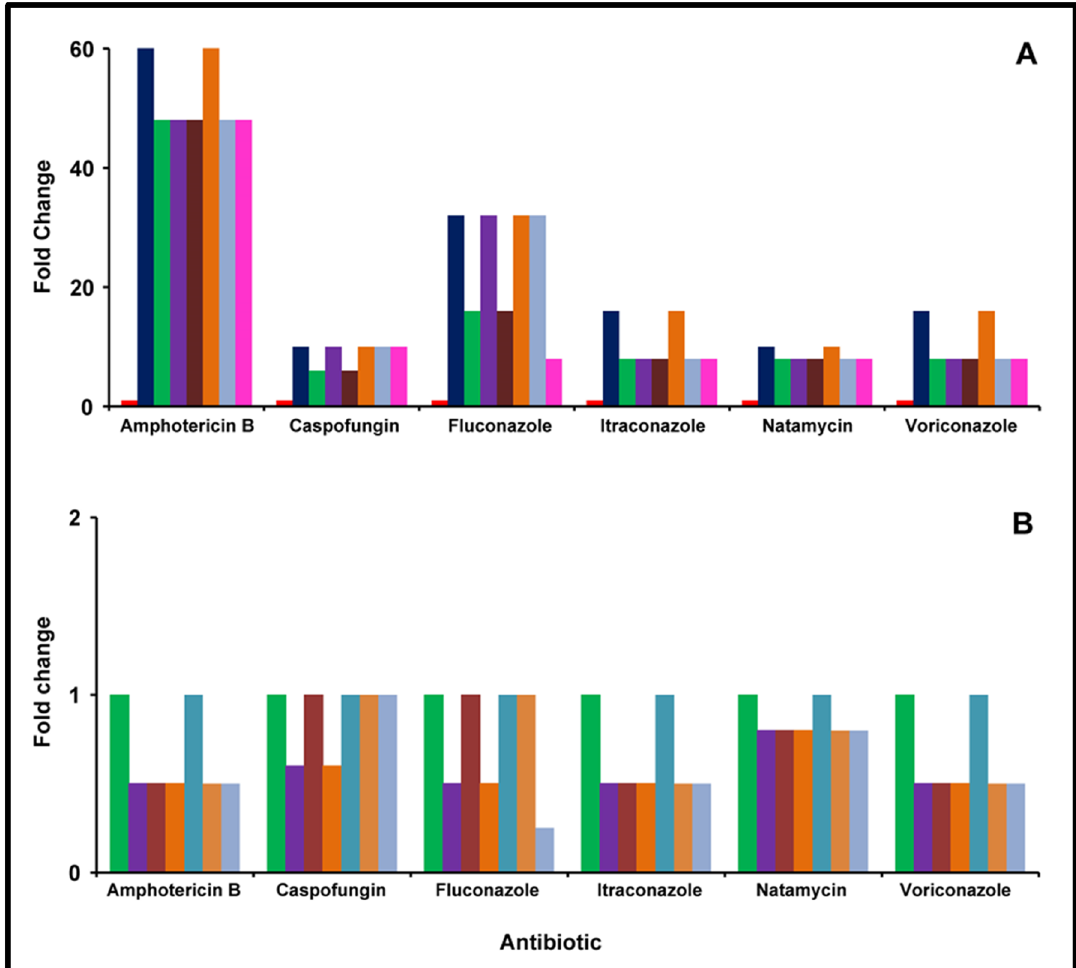
Figure 8. Fold change in the minimum biofilm eradication concentration (MBEC) of the antifungal agent of monomicrobial ( C. albicans ) and polymicrobial ( S. epidermidis plus C. albicans and S. aureus plus C. albicans ) biofilms compared to planktonic cells of C. albicans ( A ) and comparison of MBEC between monomicrobial ( C. albicans ) and polymicrobial ( S. epidermidis plus C. albicans and S. aureus plus C. albicans ) biofilms ( B ). The effect of the antimicrobial agent was evaluated by the XTT method as described. The coloured bars indicate the following: red square, C. albicans in the planktonic phase (24 h); blue square, C. albicans in the biofilm phase (24 h); green square, S. epidermidis plus C. albicans simultaneously incubated to form biofilm (24 h); purple square, C. albicans biofilm preformed for 24 h and then S. epidermidis planktonic cells were added; brown square, S. epidermidis biofilm preformed for 24 h and then C. albicans planktonic cells were added; orange square, S. aureus plus C. albicans simultaneously incubated to form biofilm (24 h); light blue square, C.